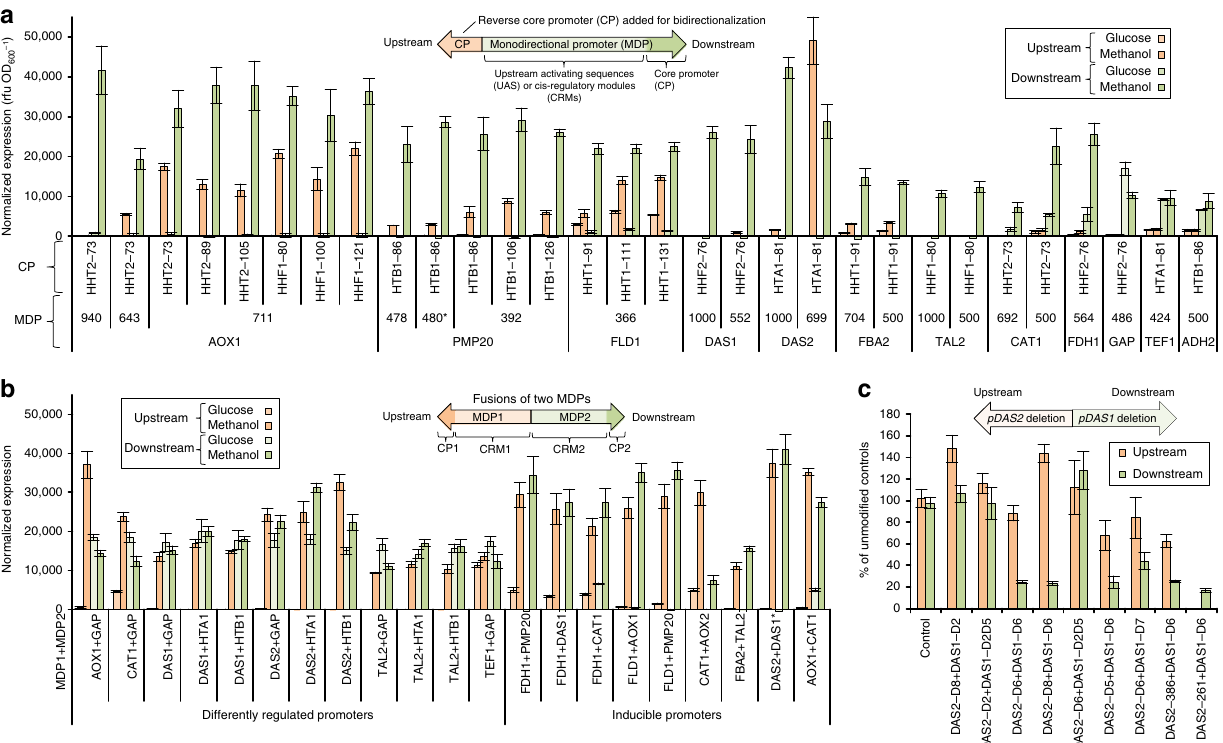
Fig. 3 Modular design strategies of synthetic bidirectional promoters (sBDPs) in P. pastoris via bidirectionalization and fusions of MDPs yield sBDPs extending the repertoire of ratios and regulatory pro fi les. a Bidirectionalization of MDPs by addition of core promoters (Fig. 2b) yielded functional BDPs in most cases, but few designs gave high expression. The core promoters (CPs) indicated were fused to the indicated MDPs. The length of the MDPs is given in bp, selection criteria are outlined in Supplementary Note 4. Asterisk (*): In case of the PMP20 promoter, slightly varying sequences from the